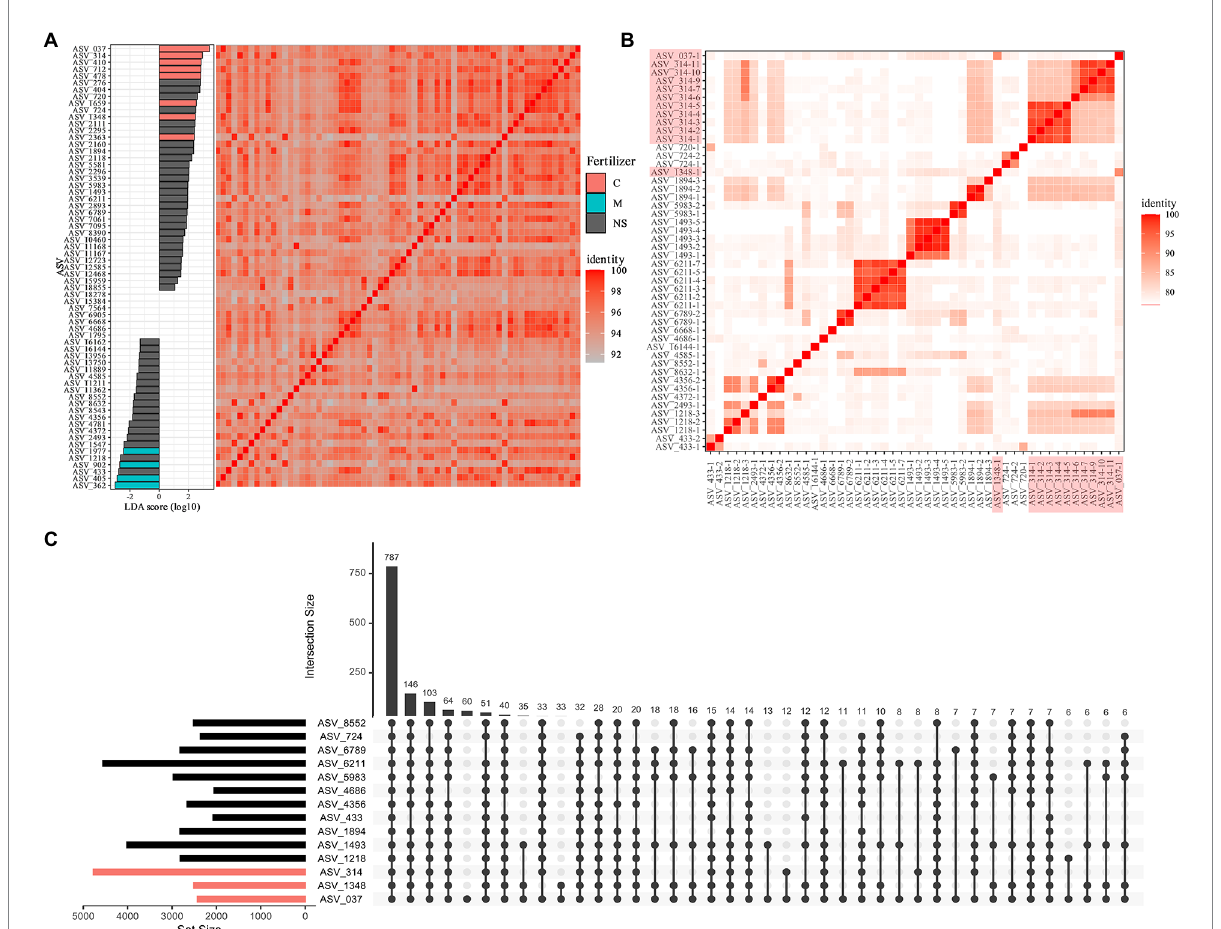
FIGURE 4 Comparative genomics of methanogenic archaea belonging to the genus Methanothrix. (A) Linear discriminant analysis effect size of Methanothrix amplicon sequence variants (ASVs). Red and blue bars represent ASVs that are significantly more abundant in chemically fertilized paddies and organically fertilized paddies, respectively. The heat map shows the homology among ASVs representative of 16S rRNA gene partial sequences. (B) Average nucleotide identity (ANI) heat map of high-quality (HQ) and medium-quality (MQ) SAGs with 16S rRNA gene sequences corresponding to Methanothrix ASVs. Axis labels highlighted in red indicate SAGs corresponding to chemical fertilizer-specific ASVs. (C) Upset diagram based on ortholog analysis between SAG datasets corresponding to each metanogenic archeal ASV. Red bars indicate SAGs corresponding to ASVs specific to chemically fertilized